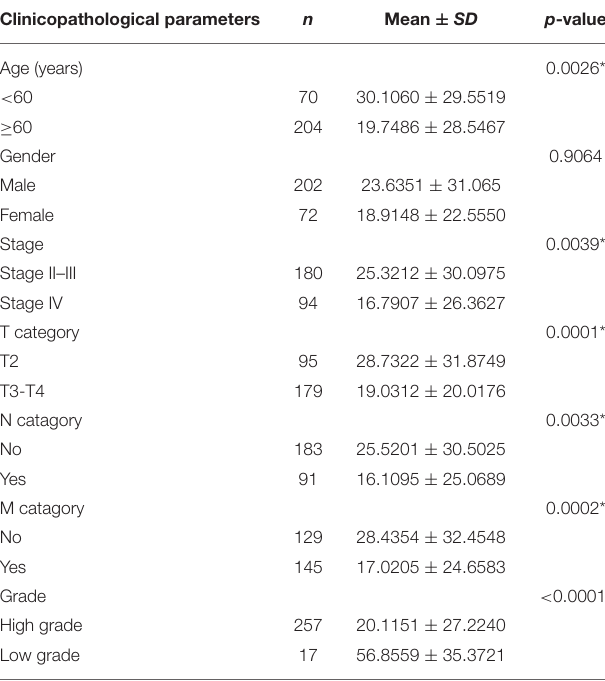
TABLE 2B | The correlations between the TMPRSS4 and clinicopathological features based on TCGA-BLCA data. Clinicopathological parameters